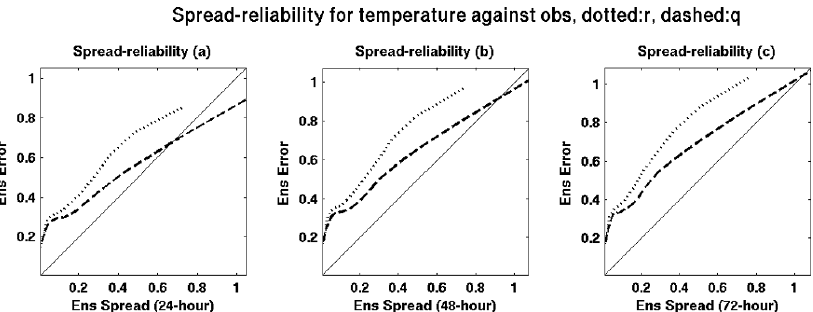
Fig. 5. Ensemble forecast spread-reliability diagrams for temperature (r: dotted, q: dashed) using observation as truth for lead times of 24, 48, and 72h (from left to right). Values are averaged over the 109days period from 1 June to 17 September 2012, and over the full observation